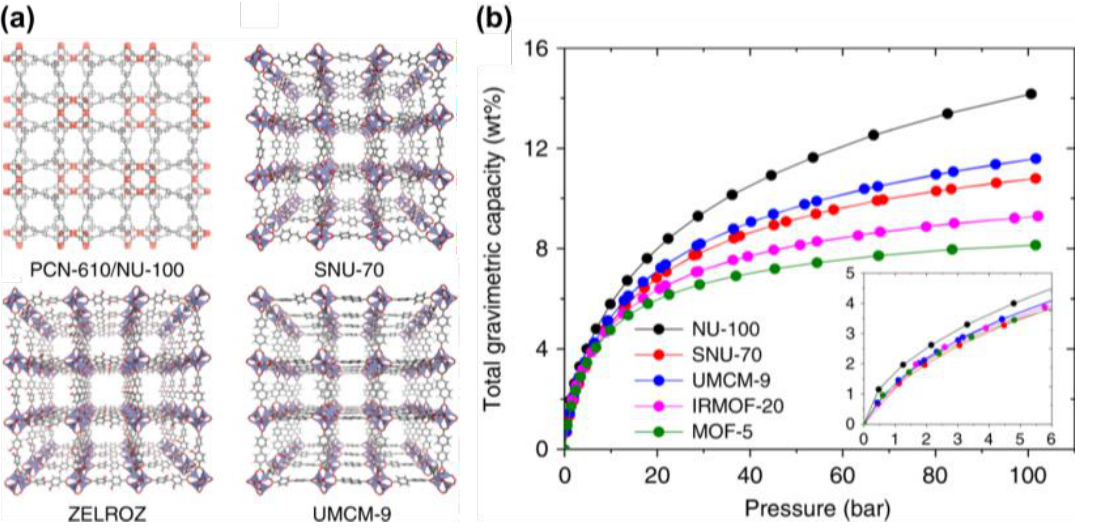
Figure 5. ( a ) Structural illustration of various types of MOF and ( b ) their hydrogen capacities at 77 K and 100 bar. Reproduced from ref. [73]; copyright (2019) with permission from Nature Research.